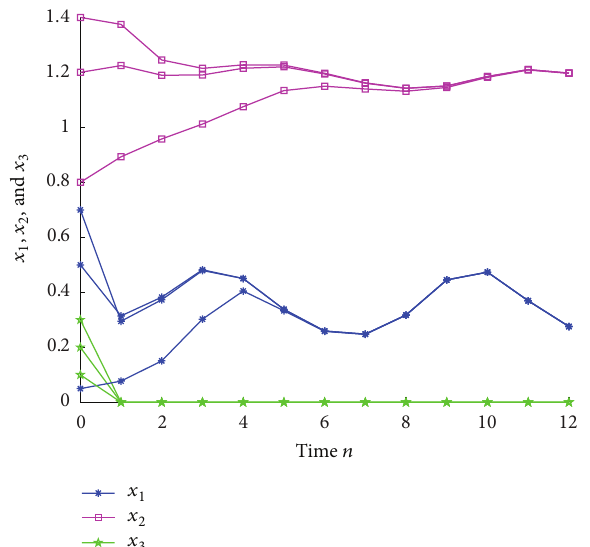
Figure 2: Dynamic behavior of the solution (𝑥 1 (𝑛),𝑥 2 (𝑛),𝑥 3 (𝑛)) to system (96) with the initial conditions (𝑥 1 (0),𝑥 2 (0), 𝑥 3 (0)) = (0.05, 0.8, 0.1),(0.5, 1.2, 0.2) and (0.7,1.4, 0.3) , respectively.